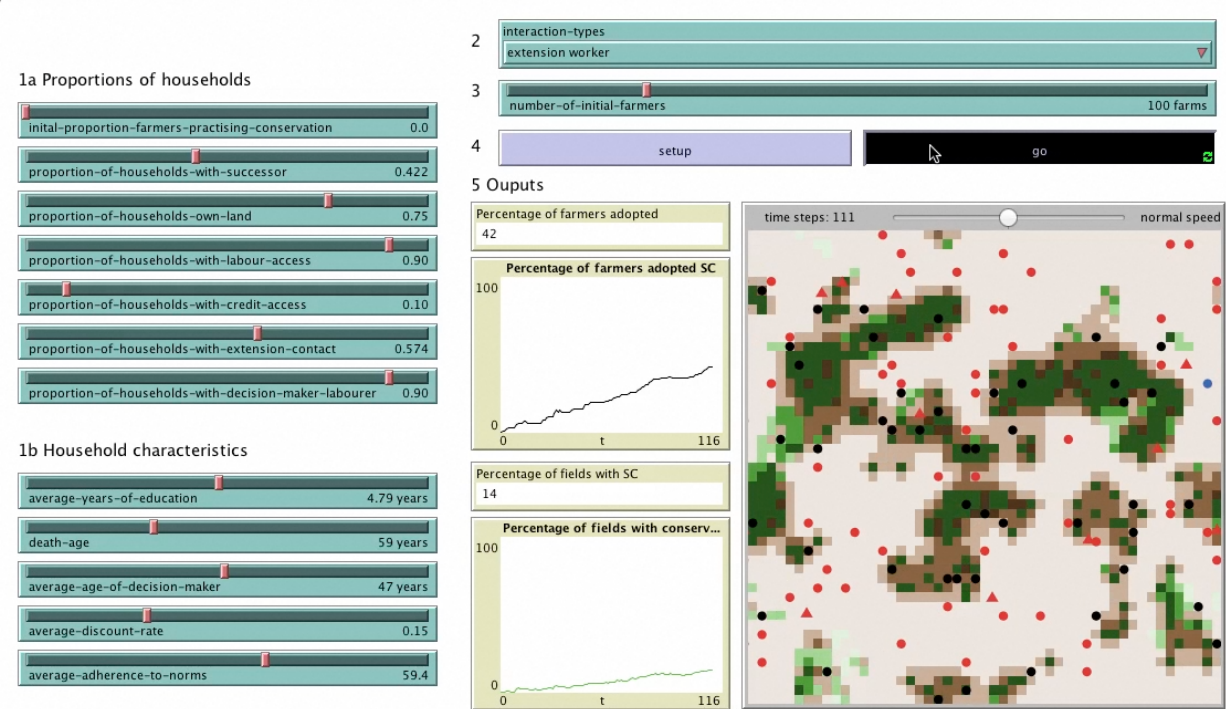
Figure 3. Screen shot of the model being run “live” for the